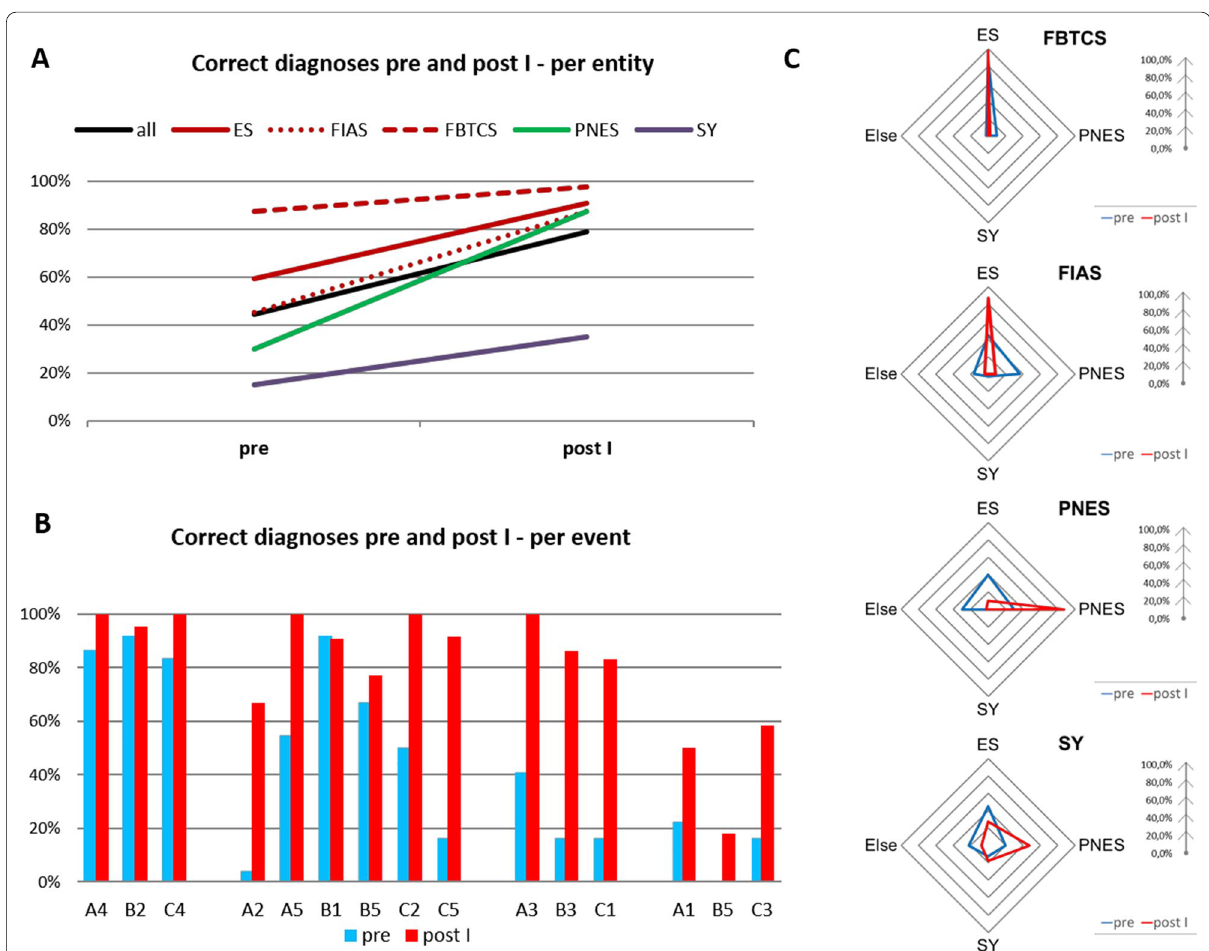
Fig. 2 A Percentage of correct diagnoses of ES, PNES and SY at time points pre and post I. For each event type except FBTCS and SY, a significant increase was observed. B Also at the single event level, an increase in correct diagnoses is given in 14 out of 15 events (only FIAS B1 with ictal speech, prominent manual and subtle oral automatisms was correctly rated before the course in 91.7% and at post I in 90.9%). SY remain misdiagnosed at post I compared to ES and PNES. C Radar plots show participant’s diagnoses at time point pre (blue) and post I (red), ES are split up into FIAS and FBTCS. Pre-course FIAS, PNES and in particular SY showed a more diverse attribution of SLE ( the diagnosis “other” (